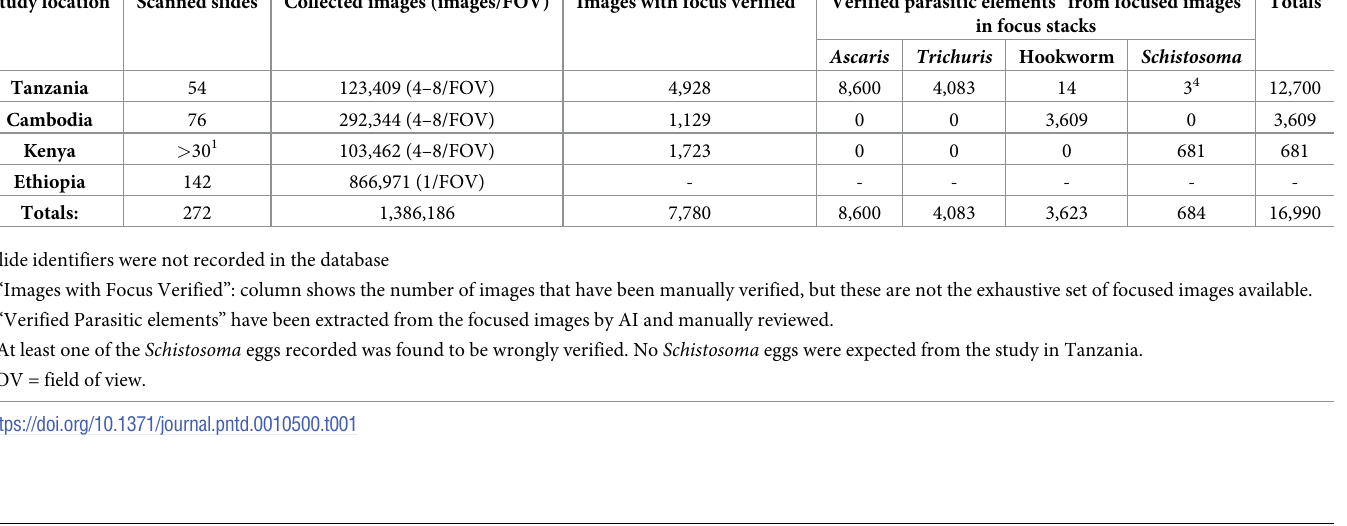
Table 1. Summary of the Kato-Katz slide images collected with the prototype WSI. Study